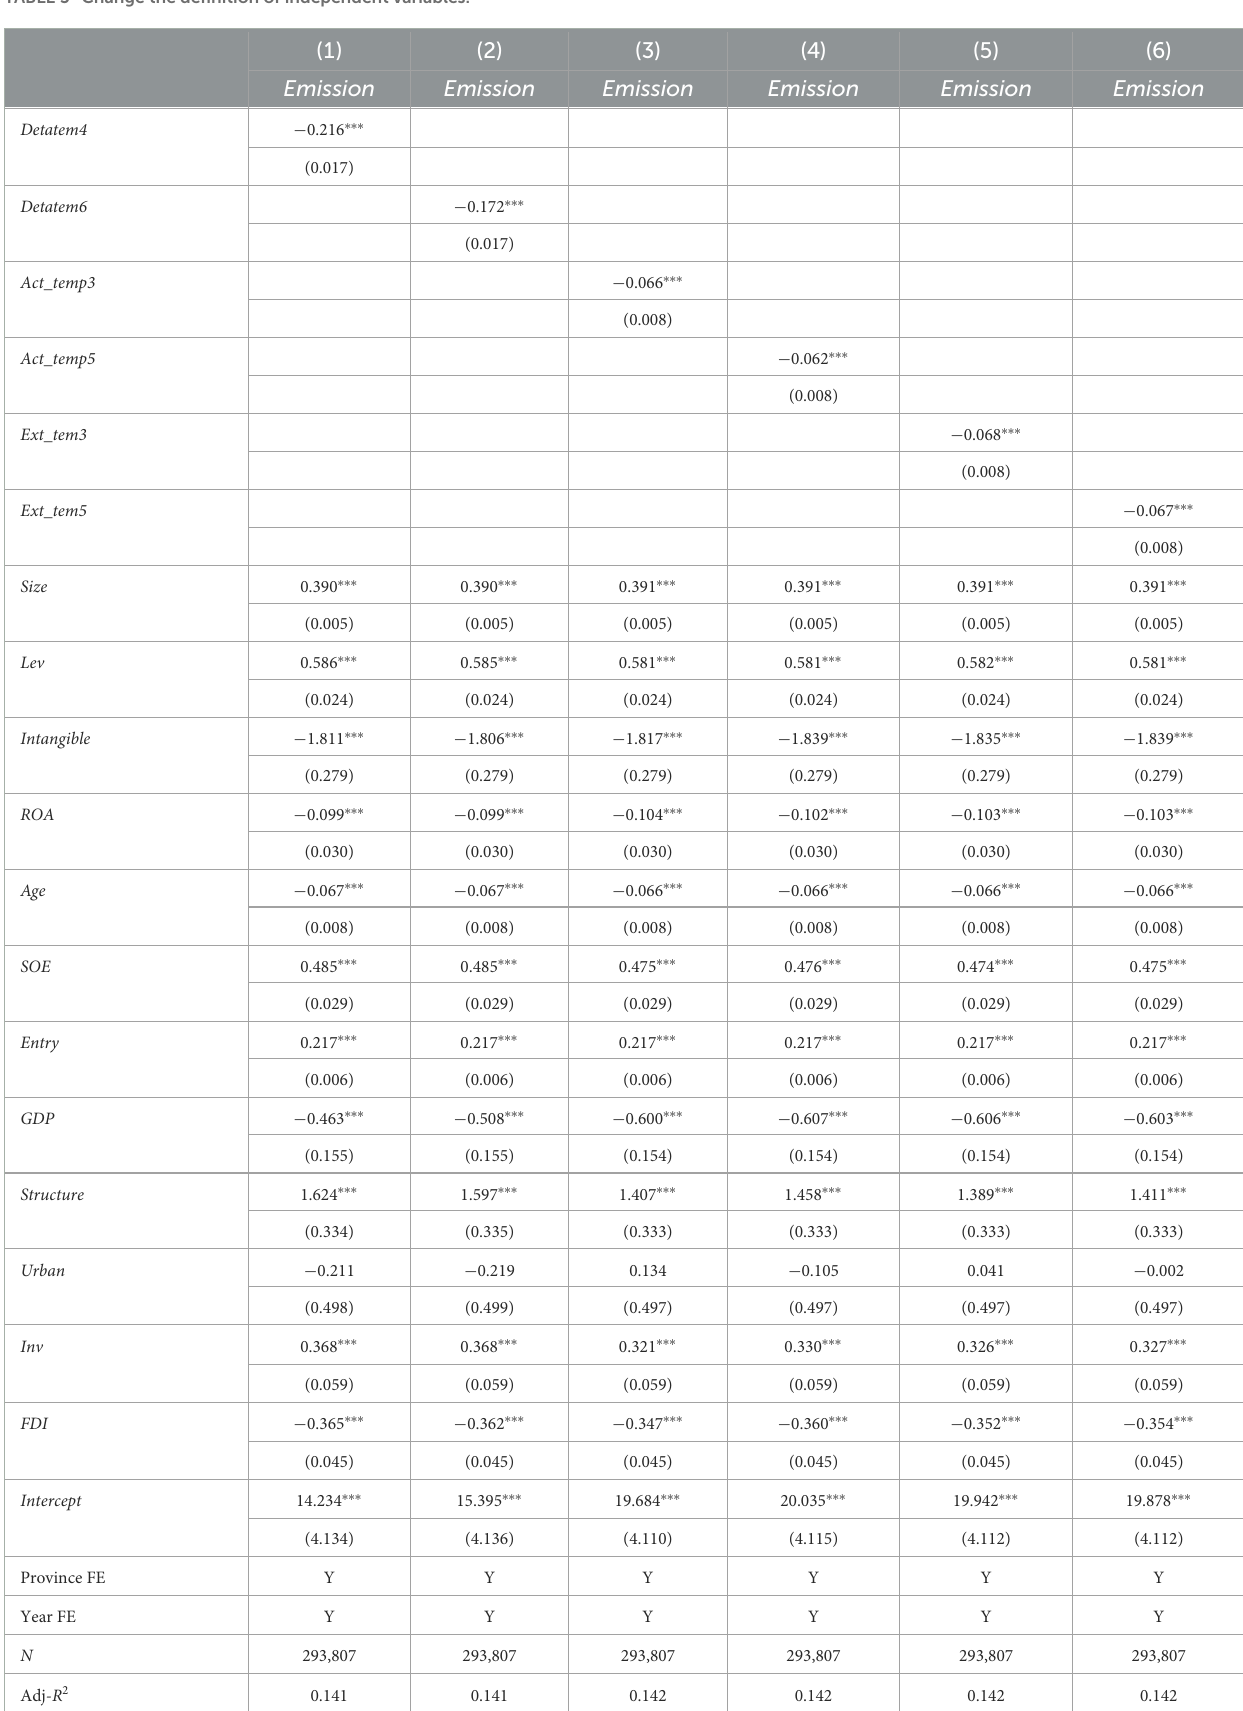
TABLE 5 Change the definition of independent